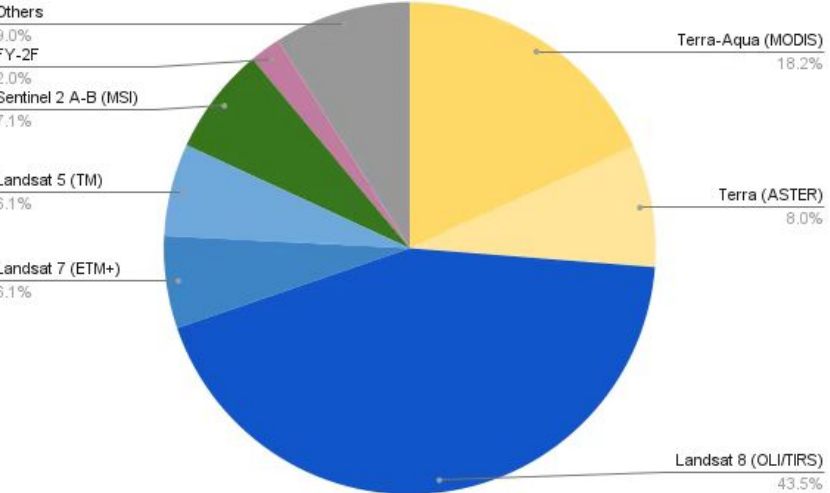
Figure 6. Satellites and sensors by